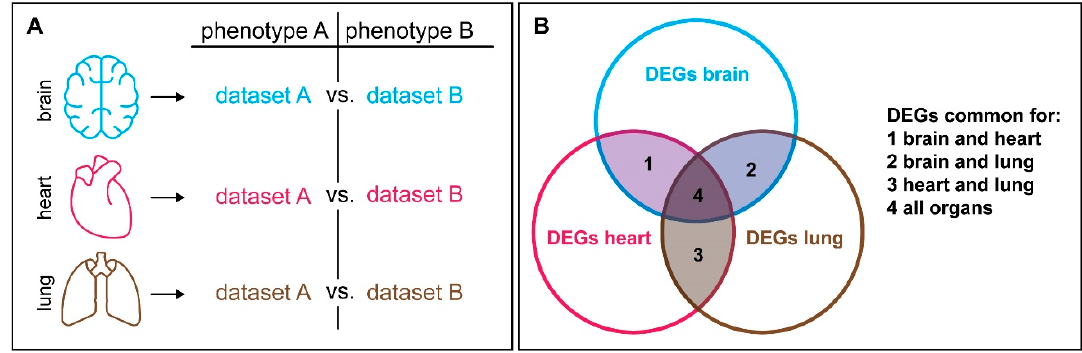
Figure 2. Generic factors that are expressed across different tissue can be excluded in correlation studies. ( A ) If specific candidate genes that are differentially expressed between phenotype A and B are supposed to be revealed, one can generate a comparable dataset for additional tissues. ( B ) Each pairwise comparison will reveal a certain number of differentially expressed genes (DEGs). The DEGs that are common in two (1–3) or all organs (4) are most likely generic factors that may be less informative for follow-up analyses.